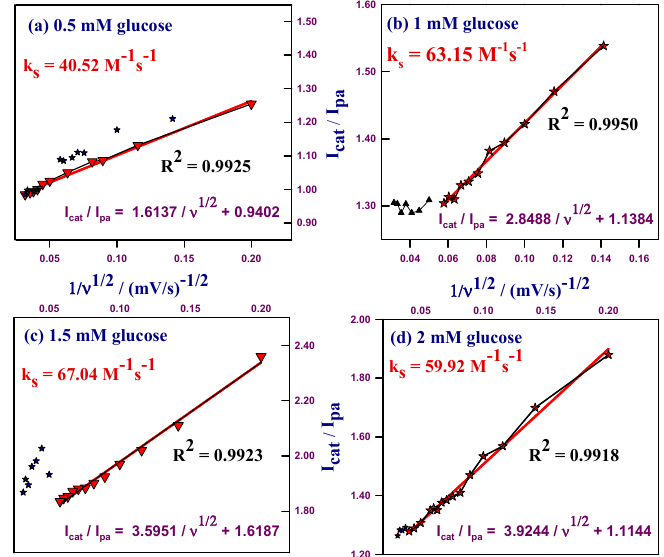
Figure 5. Plot of I cat / I pa vs. 1/ ν 1/2 for rate constant studies on a HCNiO/GC electrode in different concentrations of glucose in 0.05 M NaOH at different ν (25–900 mV/s) ( a ) 0.5 mM glucose; ( b ) 1 mM glucose; ( c ) 1.5 mM glucose; and ( d ) 2 mM glucose.